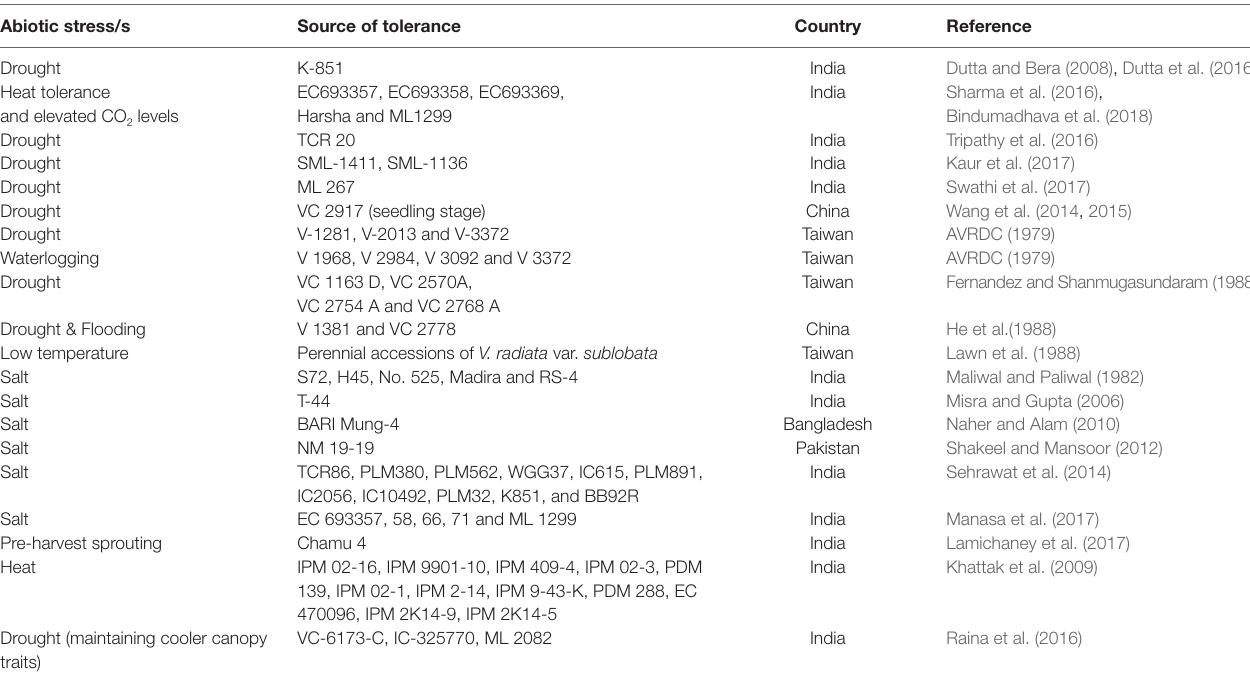
TABLE 4 | Tolerant/resistant sources of mungbean against abiotic